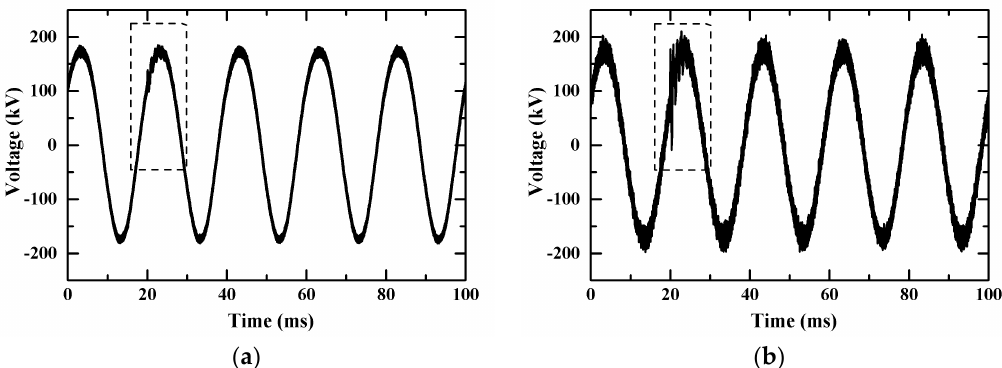
Figure 7. Voltage waveforms recorded on 13:58:27, May 14th, 2017. ( a ) Field measured results in Y-substation; ( b ) field measured results in Z-substation.